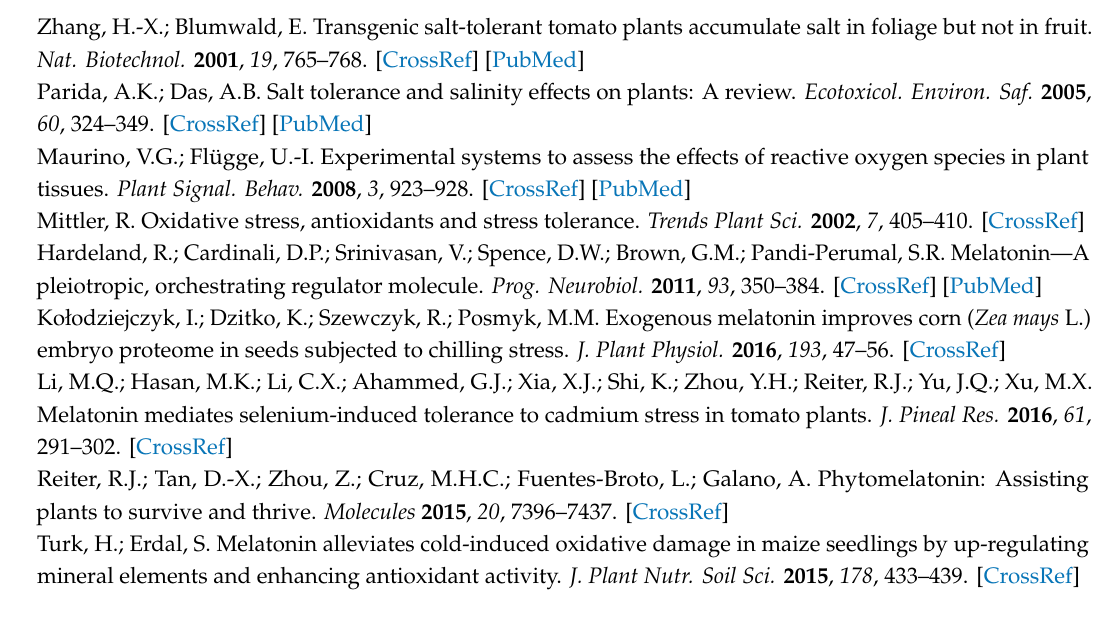
Table S1: For each protein-coding gene, a model with a BIC score (Bayesian Information Criterion) are considered to describe the substitution pattern the best. For each model, non-uniformity of evolutionary rates among sites is modeled by using a discrete Gamma distribution ( + G) with 5 rate categories and by assuming that a certain fraction of sites is evolutionarily invariable ( + I). Assumed or estimated values of transition / transversion bias (R) for each model as well as nucleotide frequencies (f) and rates of base substitutions (r) for each nucleotide pair are shown. The analyses were conducted in MEGA X. Table S2: Primers sequences for semi-quantitative and quantitative RT-PCR of the salt-related genes in Peanut ( Arachis hypogaea L. cv. NC-9) seedlings, Table S3: Description of 5 protein-coding genes extracted from di ff erent plant hosts and their corresponding accession numbers. The asterisk indicates the sequence amplified from Arachis hypogaea (this